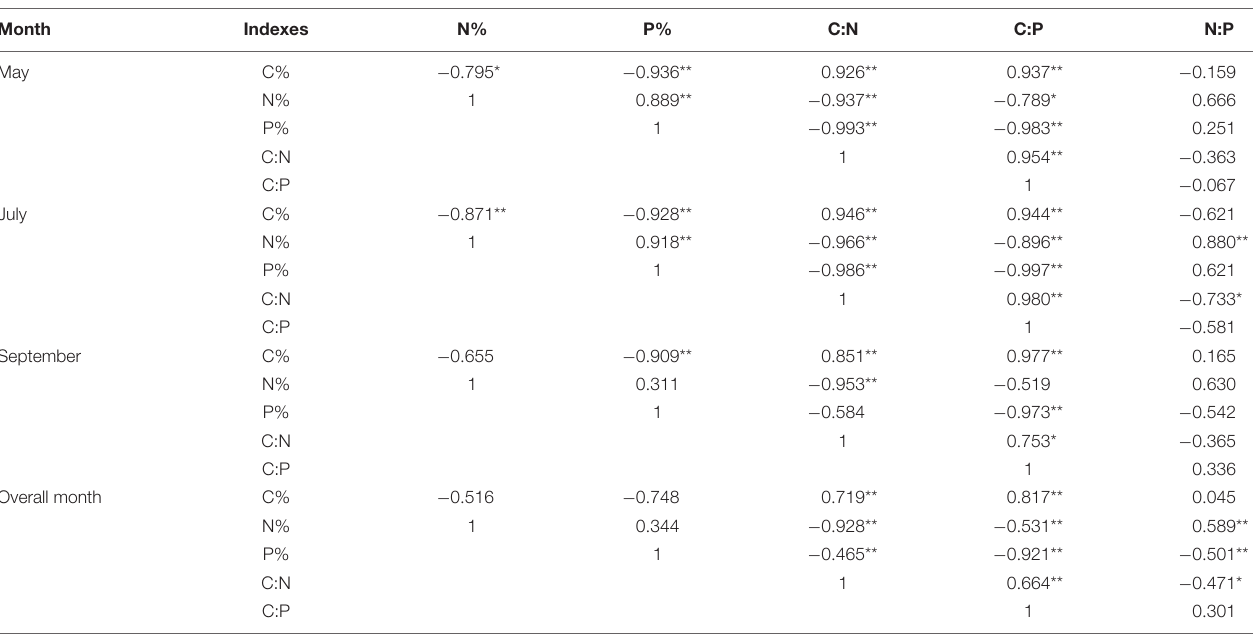
FIGURE 1 | Seasonal dynamics of C, N, and P stoichiometry in different organs of M. sibirica. Different capital letters indicate the significant difference in the same organ in different months, and different small letters indicate the significant difference between different organs in the same month. TABLE 1 | Correlation of C, N, and P Stoichiometry in different months of M. sibirica